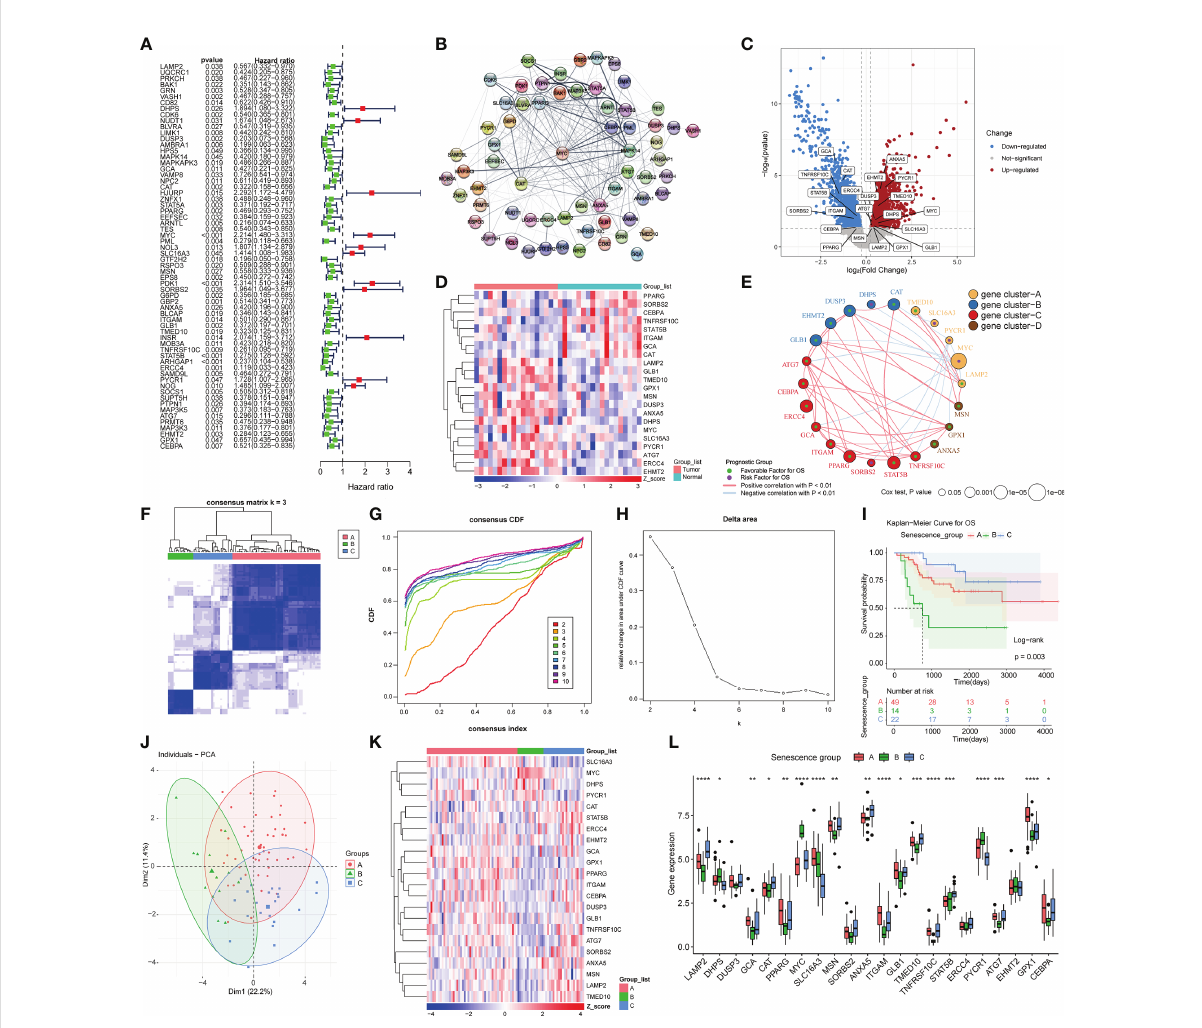
FIGURE 1 Prognostic gene screening and consensus clustering. (A) Univariate Cox regression of ASIGs for the screening of prognosis-related genes. (B) Construction of a PPI network of 64 prognosis-related genes using STRING. (C) Differential expression analysis of osteosarcoma samples and adjacent samples in GSE99671 (p-value< 0.05 and log2FC > 0.25). (D) Heatmap of 22 prognosis-related differences in ASIGs in GSE99671. (E) Coexpression network of 22 prognosis-related genes in TARGET-OS (p-value< 0.05 and correlation > 0.3). (F) Heatmap of the consensus matrices for k = 3. (G, H) Consensus cumulative distribution function (CDF) plot for 22 ASIGs in TARGET-OS. (I) Kaplan – Meier curves based on three clusters in the TARGET-OS. (J) Principal component analysis (PCA) of the three subgroups. (K, L) Heatmap and box plot of 22 prognosisrelated ASIGs in the three subgroups (*p< 0.05, **p< 0.01, ***p< 0.001, ****p<